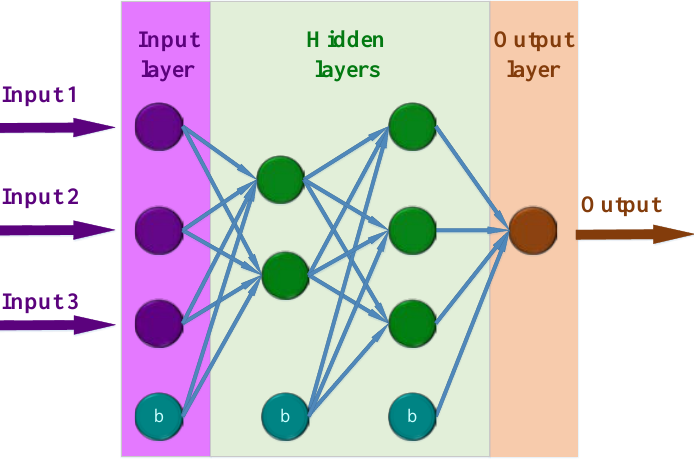
Figure 2. A schematic